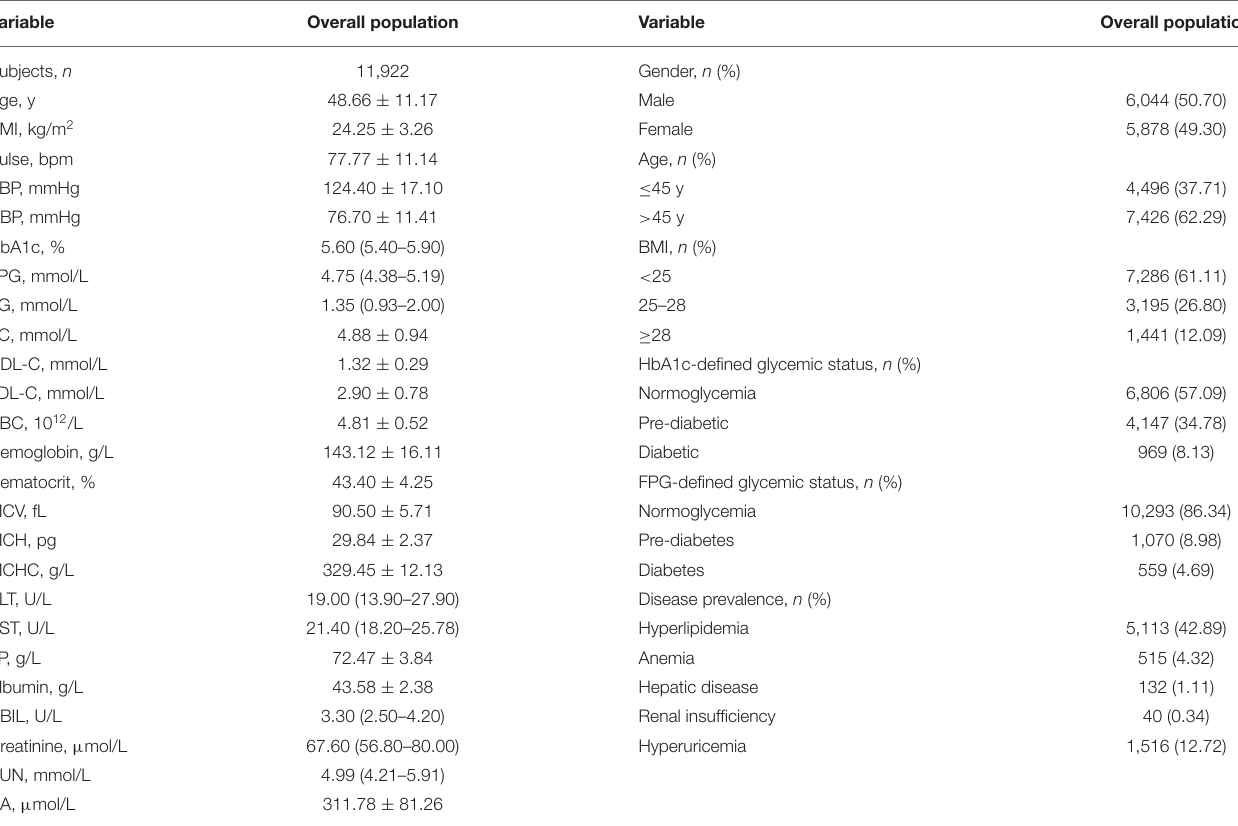
TABLE 1 | Baseline characteristics of the study